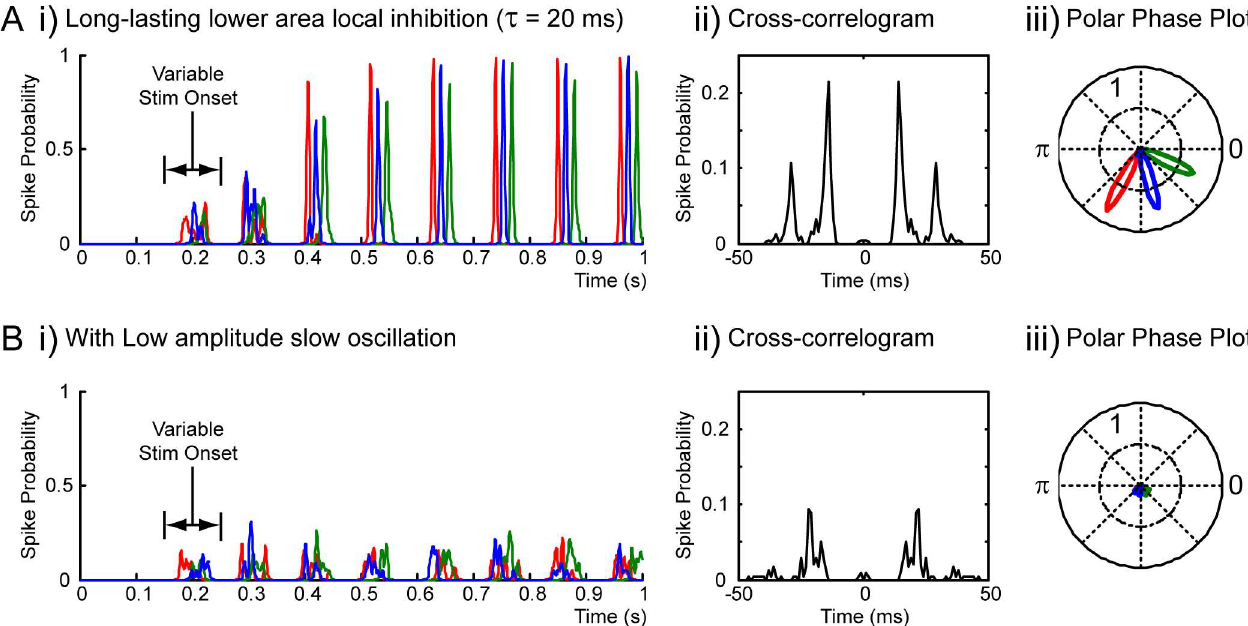
Fig 6. LJ-multiplexing–representation of multiple items. A. The system is capable of representingmore objects (more closely matching the proposalsof the LJ-multiplexing theory), provided that ensembles auto-inhibit for a longer period, and therefore fire only once per slow cycle. Results from a series of simulations (100 repeats), summarizing activity in the higher area (red for high contrast object, blue for mid, green for low). Parameters as for Fig 3D (i.e. strong global inhibitionin the lower area), except that the synaptic decay time constant for local inhibitionin the lower area was increasedto 20 ms. Following200 ± 50 ms of blank screen, the stimulus (3 objects, see text) was turned on. i) shows a PSTH (spike probability across simulation repeats), ii) is a cross-correlogram (calculated for spikes from all 3 cells), iii) shows a polar phase plot of firing probabilityrelative to the slow oscillation. B . As for A, except that the amplitudeof the slow oscillationwas halved, such that some lower area cells were never fully suppressed. Again (c.f. F-multiplexing, Fig 5D), lower area synchrony was disruptedand object representation was